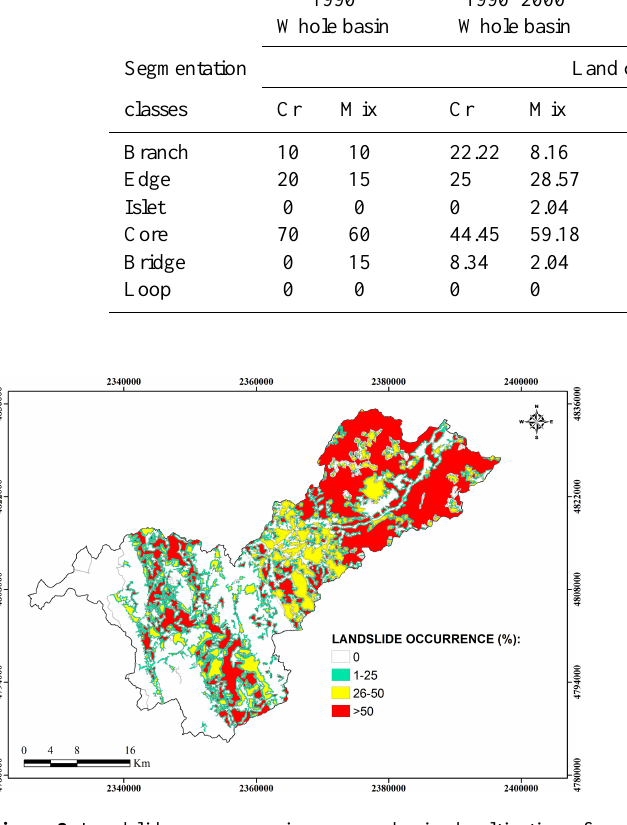
Figure 3. Landslide occurrence in crops and mixed cultivation of the Esino river basin during the November 2013 and May 2014 rain- fall events. Red areas represent the vegetation segmentation classes in which more than the 50% of the landslides were recorded, yellow areas the classes in which 26–50% of the landslides were recorded, and green areas the classes in which less than 25% of the landslides were recorded. White areas are those not affected by